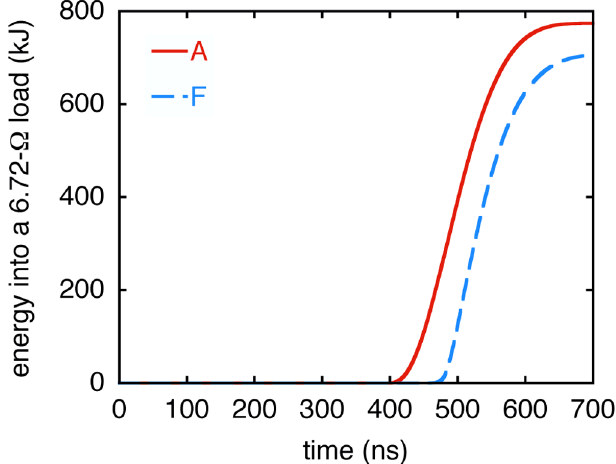
FIG. 8. (Color) The energy in the main power pulse for current shapes A and F.